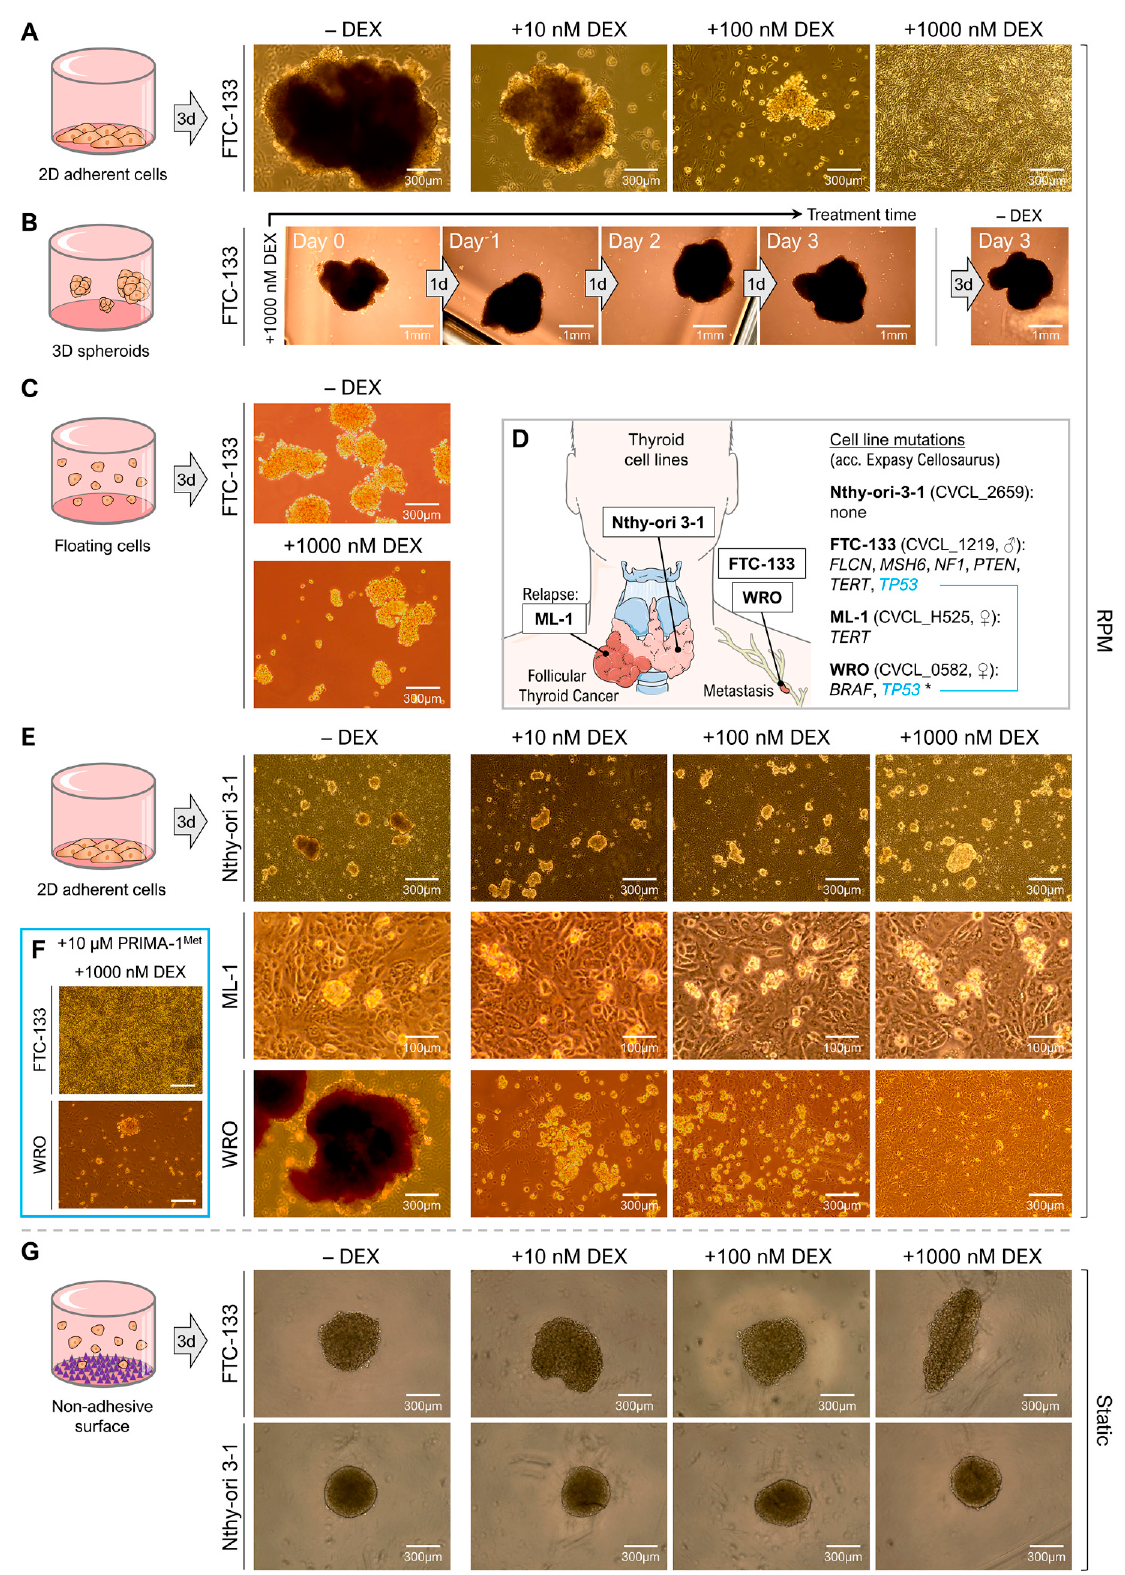
Figure 2. Impact of different DEX concentrations (0, 10, 100, 1000 nM) on spheroid formation and stability of different thyroid epithelial cells after 3 days. ( A ) Spheroid formation of adherent FTC-133 metastasized carcinoma cells after rotation on the RPM; ( B ) stability of preformed FTC-133 spheroids on the RPM in the presence of 1000 nM DEX; ( C ) spheroid formation of FTC-133